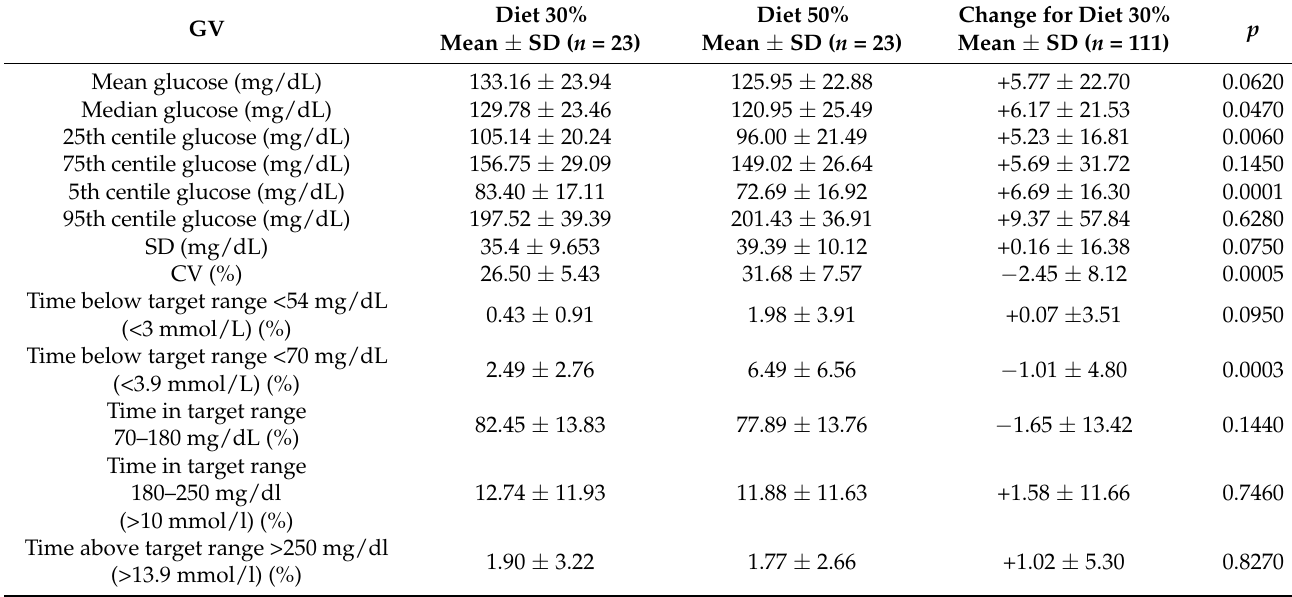
Table 3. Comparison of glycaemic parameters based on used